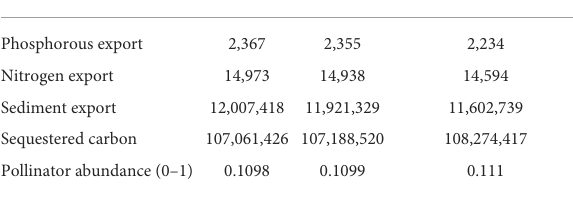
TABLE 1 Baseline, buffered, and productivity-based scenario outputs for ecosystem services generated by InVEST (v 3.7.0) in the Grand River Basin, Iowa and Missouri,